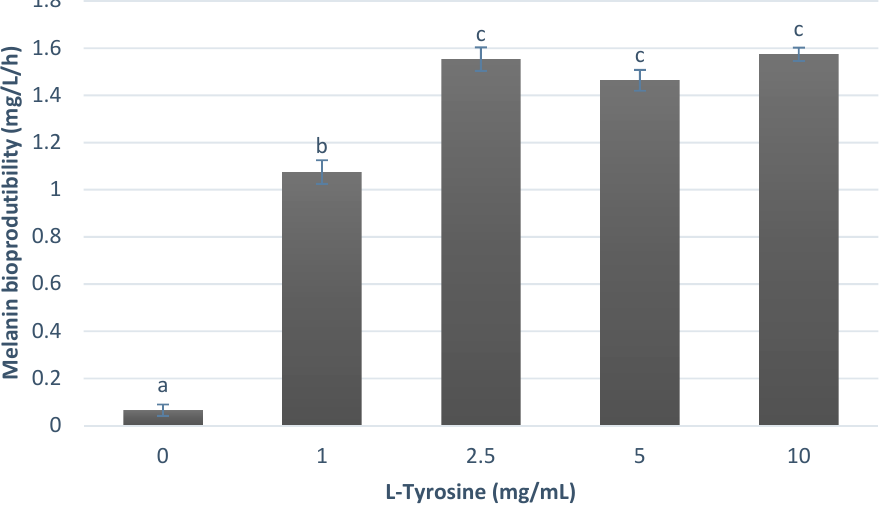
Figure 3. Melanin bioproductibility (mg/L/h) by P. putida ESACB 191, using different concentration of L-tyrosine in the culture medium. The error bars values were calculated based on three replicates for each condition; different superscript letters (a, b, c) correspond to values in the same quantification condition that can be considered statistically different 95% confidence